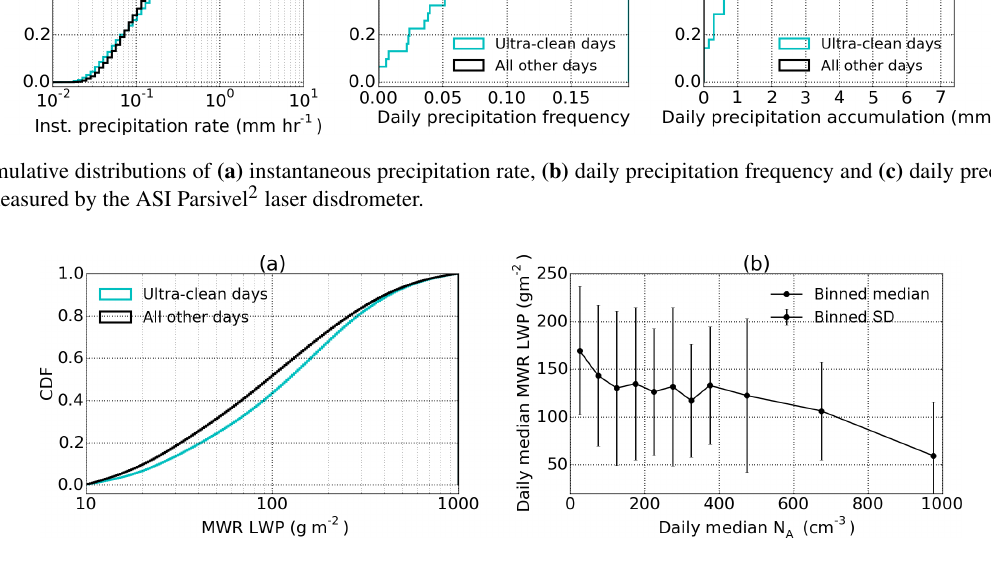
Figure 5. (a) Comparison of the cumulative distributions of best-estimate LWP retrieval from the ASI MWR between ultra-clean and all other days and (b) medians and standard deviations of daily median MWR LWP across bins of daily median accumulation mode aerosol for the entire LASIC record. In panel (b) , bin widths were selected to account for varying density of days across the range of aerosol concentrations while still visualizing the broader